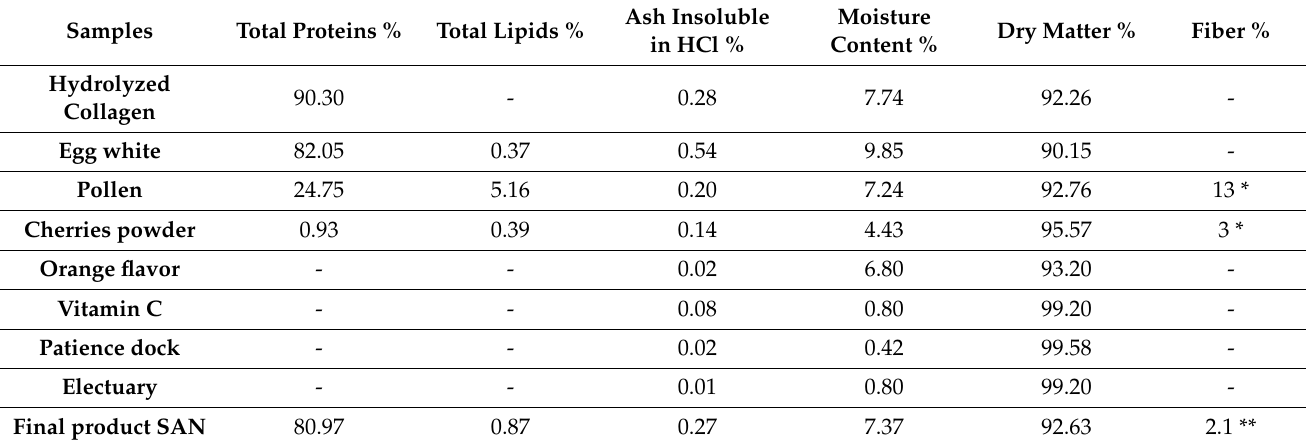
Table 1. Nutritional status and physico-chemical properties of ingredients and final